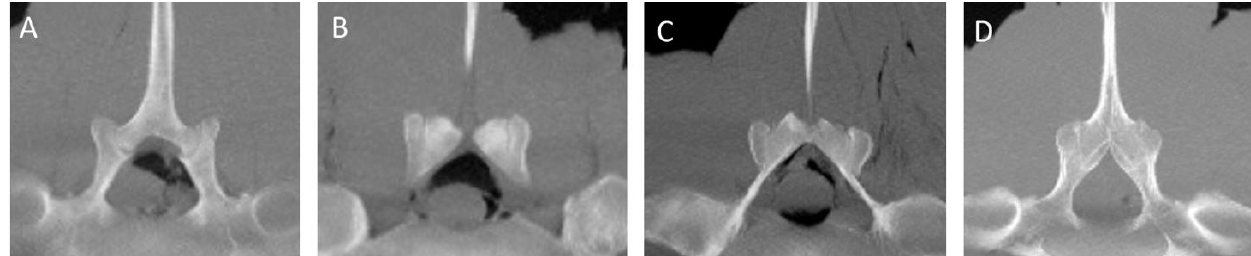
Figure 5. Transverse multiplanar reconstruction computed tomographic images ( A – D ) of the lumbar specimens 12, 23, 34, and 25, using maximum intensity projection (MIP); the dorsal is toward the top of the images. There are bilateral mild ( A ), moderate ( B ), and severe ( C ) periarticular osseous changes involving the cranial aspect of the L(ii)-L(i) articular processes joints (APJs). ( D ) There is also complete obliteration of the APJs joint space (ankylosis). L(ii): second to the most caudal lumbar vertebra; L(i): the most caudal lumbar vertebra. Table 4. Number ( n ) and prevalence (%) of degree of pathological changes of the L(iv)-L(i) articular processes joints (APJs) for 40 specimens that underwent post-mortem computed tomographic evaluation of the caudal lumbar region. L: left; R: right; B: bilaterally; S: symmetry; L(iv): fourth to the most caudal lumbar vertebra; L(iii): third to the most caudal lumbar vertebra; L(ii): second to the most caudal lumbar vertebra; L(i): the most caudal lumbar vertebra. Severity of Osseous Pathological Changes Mild Moderate Severe Ankylosis n (%) n (%) n (%)